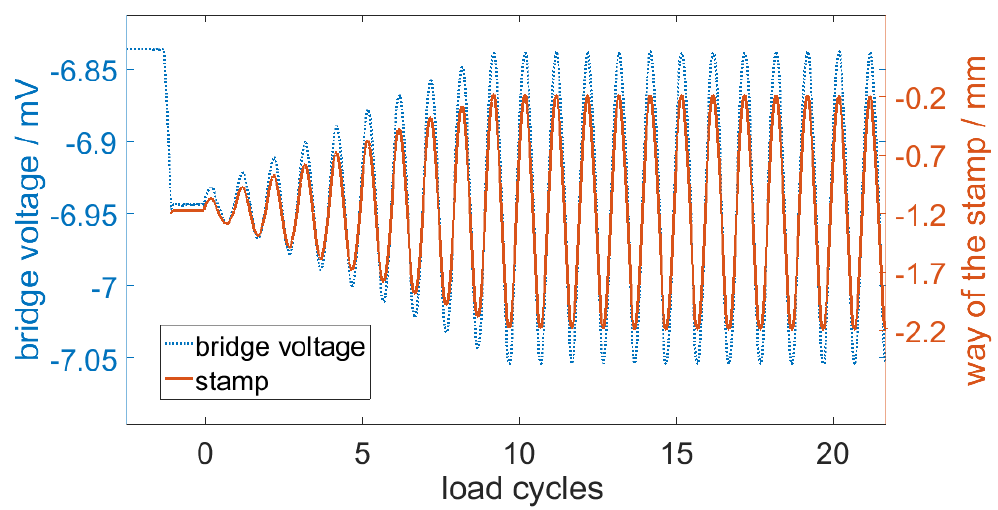
Figure 7. The measurement signal of the bridge voltage with the way of the stamp.